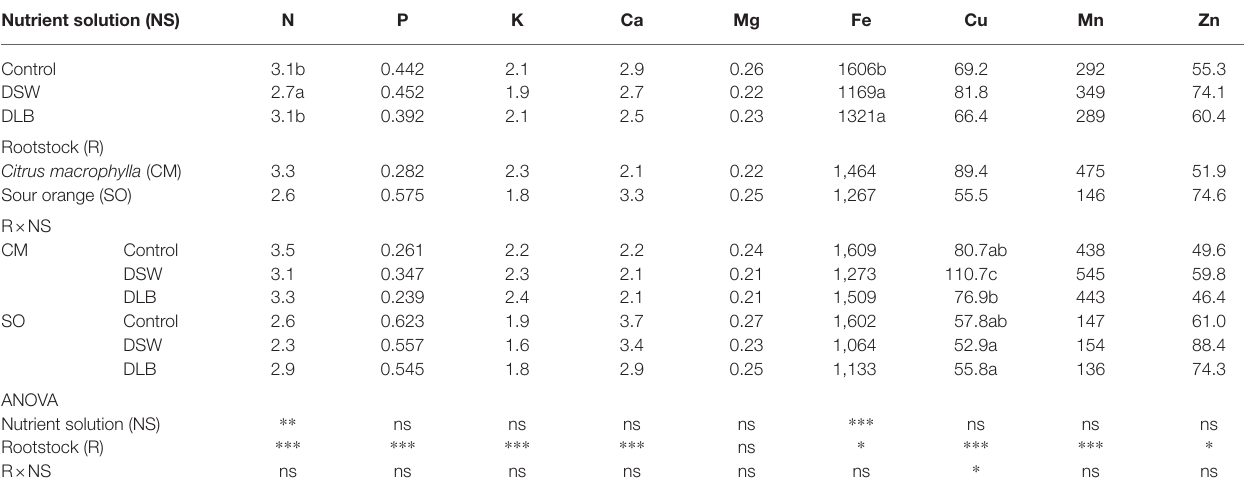
TABLE 5 | Effects of 7 months of irrigation with nutrient solutions of different characteristics—Control, DSW, and DLB—and the rootstock on the root mineral nutrition of ‘Verna’ lemon plants grown on two rootstocks, Citrus macrophylla (CM) and sour orange (SO). Nutrient solution